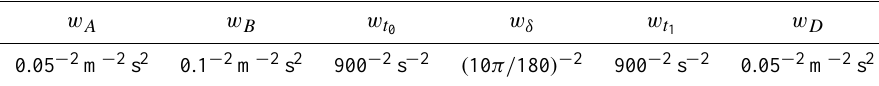
Table 1. Weighting parameters used for the cost function Eq. (9).